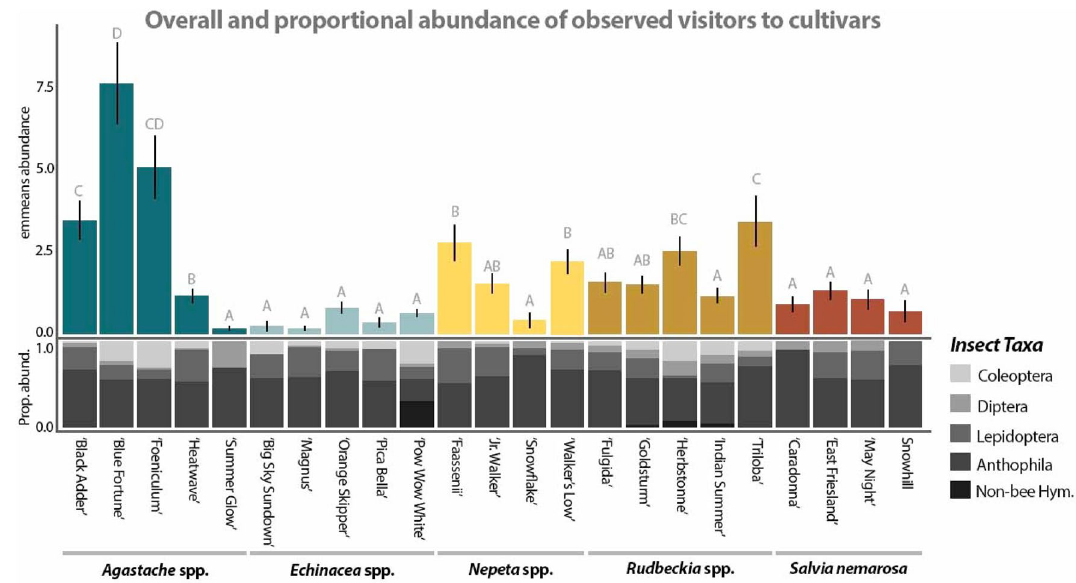
Figure 2. Estimated marginal means (emmeans) of total visitor abundance and mean proportional abundance of observed insect pollinator visitors. Cultivars within some genera vary greatly in total visitor abundance as well as proportional abundance of visitors, while there is little variation between cultivars of other plant genera. Anthophila species are the primary visitors observed in this system, however certain cultivars within genera attract unique pollinator functional